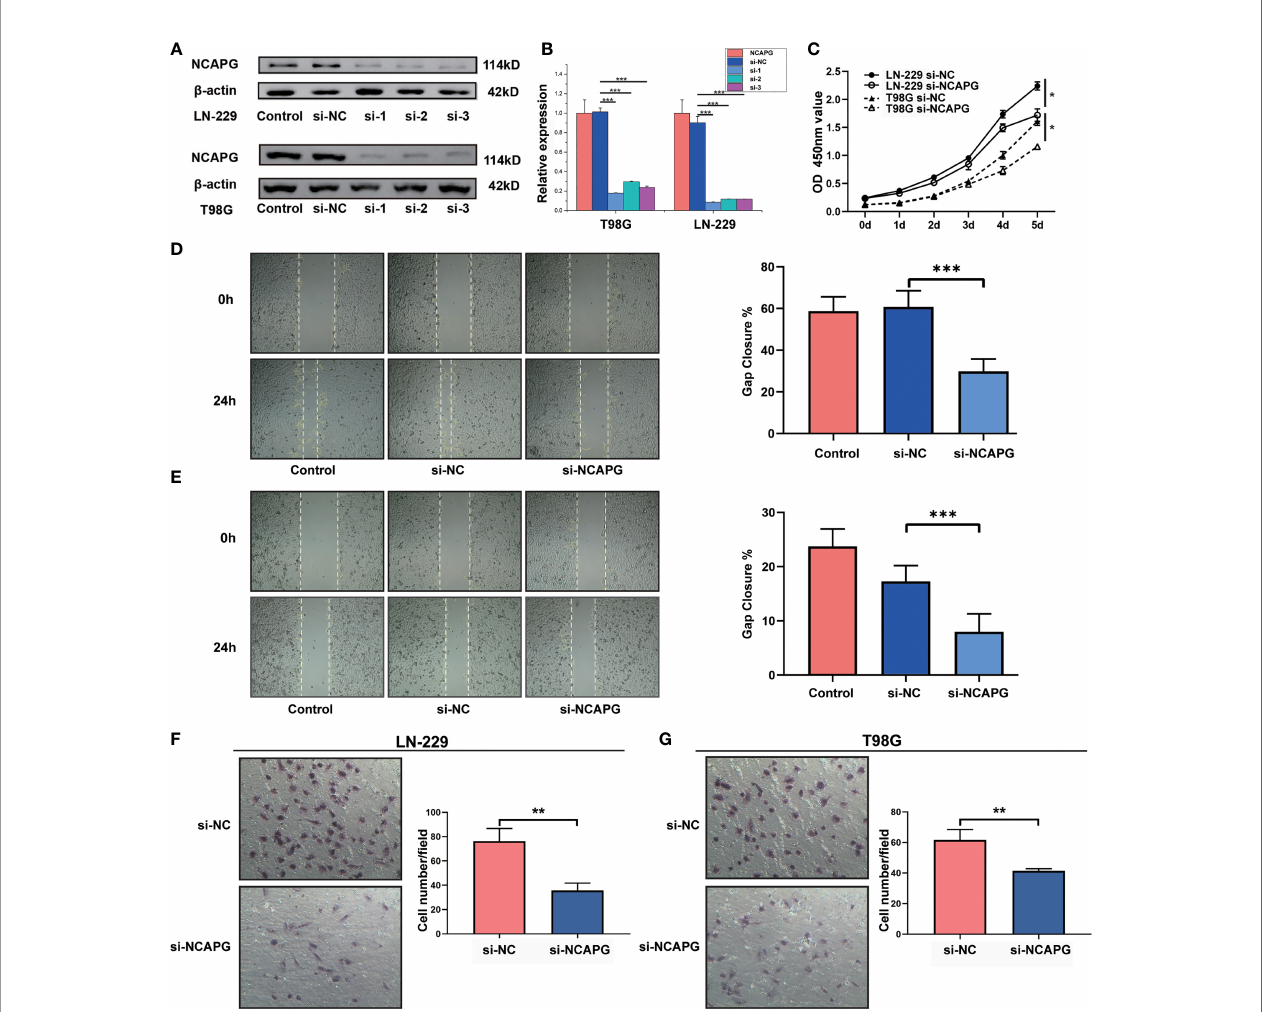
FIGURE 4 | NCAPG promotes the proliferation, migration, and differentiation of glioma. (A) NCAPG expression in LN-229 and T98G cell lines were analyzed using western blot after transfection with si-NC, si-1, si-2, and si-3. (B) Quantitative analysis of the expression of NCAPG in LN-229 and T98G cell lines by western blot and RT-qPCR. (C) Cell viability of LN-229 and T98G cell lines at different time points after incubation, analyzed by CCK-8. (D, E) Cell scratch test was used to detect the healing rates of LN-229 and T98G cell lines. (F, G) Transwell invasion assay was used to detect the invasion ability of both LN-229 and T98G cell lines. (*P < 0.05, **P < 0.01, ***P <